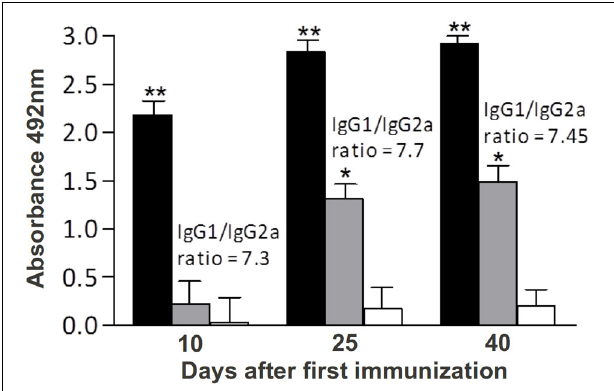
FIGURE 3 | Kinetics of specific anti-rSMYB1 IgG, IgG1, and IgG2a antibodies in sera from mice vaccinated with rSMYB1. Sera were collected from 10 immunized mice per group prior to the first immunization and at days 10, 25, and 40 after the first immunization and assayed by ELISA. The results are presented as the mean absorbance at 492nm for each isotype on each day of sera collection. Asterisks indicate statistically significant differences between the vaccinated and preimmune groups: ∗ p < 0 . 05; ∗∗ p < 0 . 01. Black bars: IgG antibody. Gray bars: IgG1 antibody. White bars: IgG2a antibody. The results are representative of two independent biological replicates.